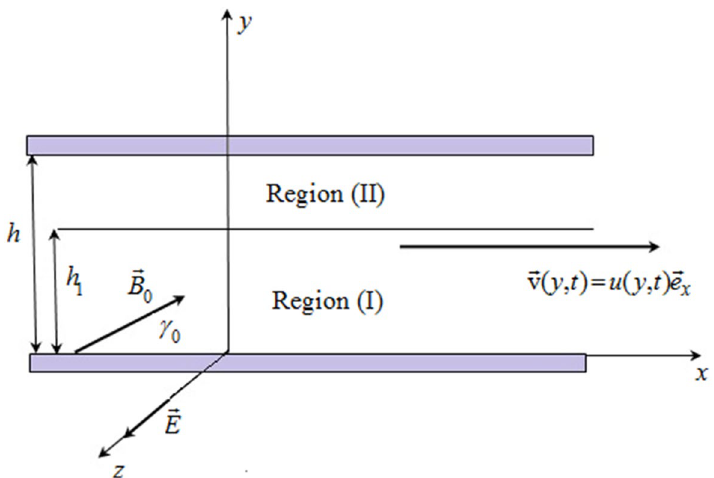
Figure 1. Physical model. Coordinate